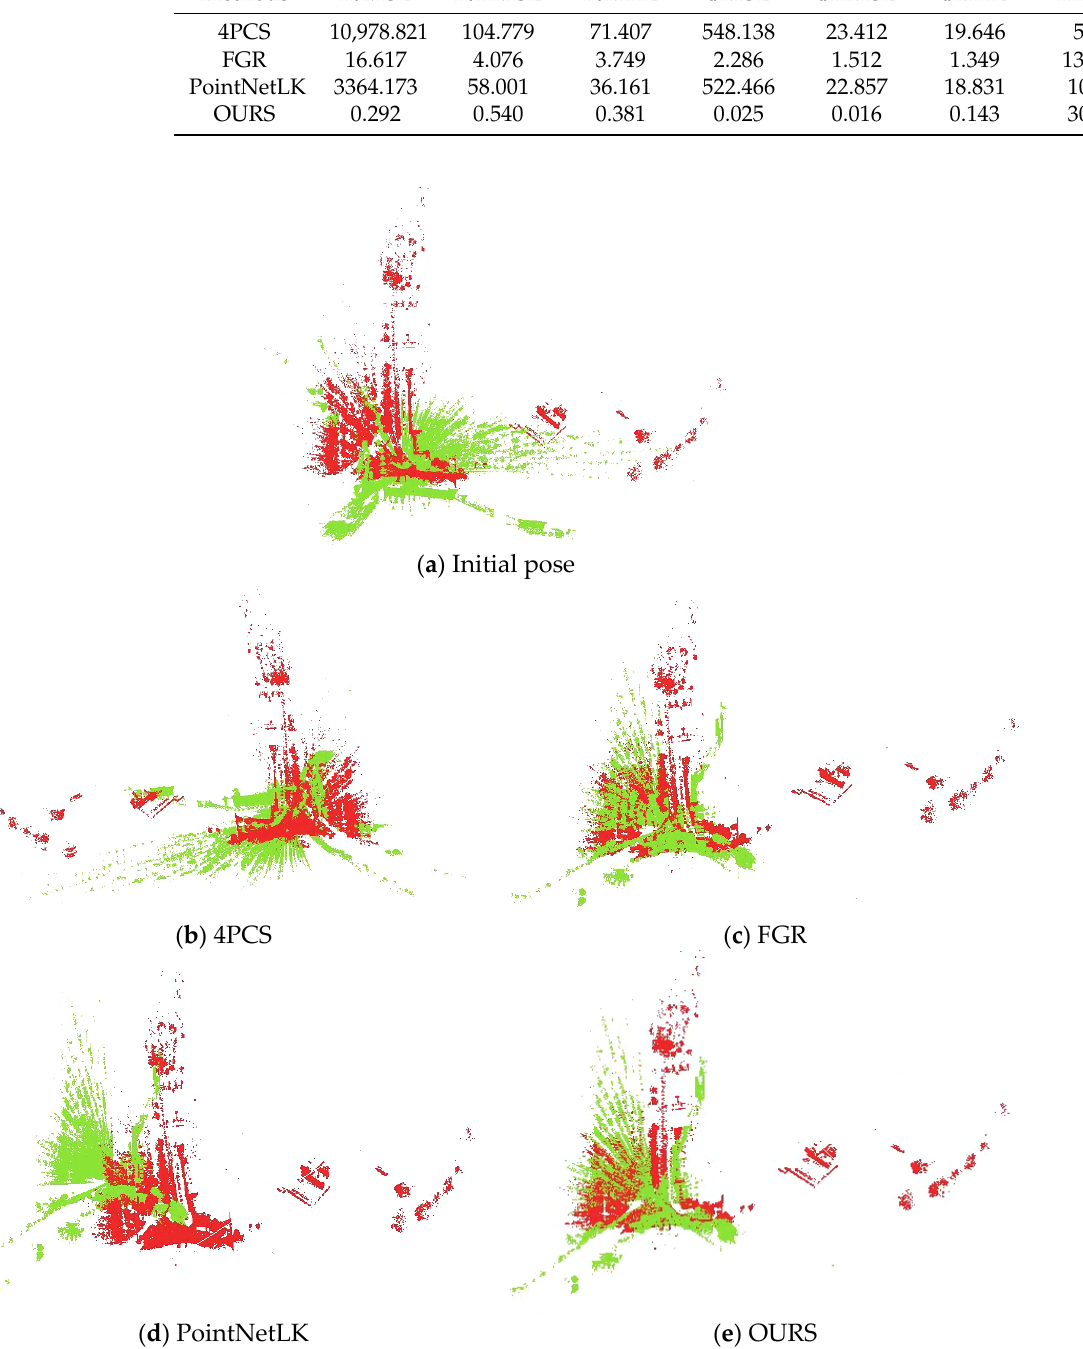
Figure 7. Registration results of each algorithm for park